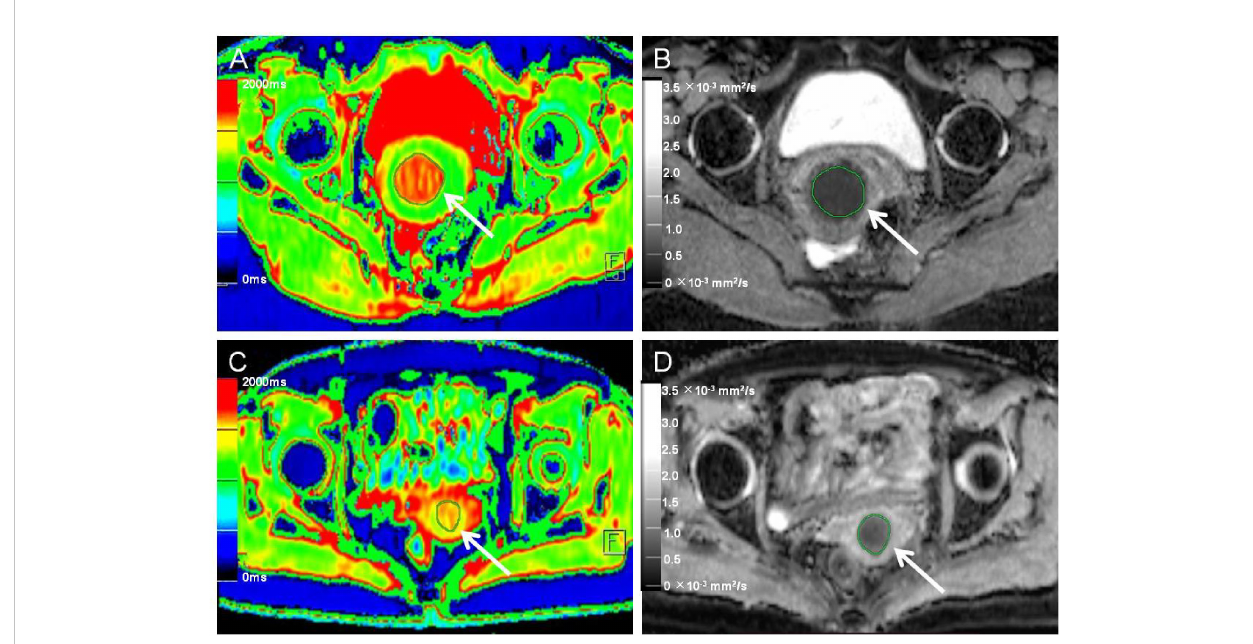
FIGURE 2 Native T1 mapping and apparent diffusion coef fi cient (ADC) images of recurrent and nonrecurrent cervical cancer (CC) in the surgical group. (A, B) A 45-year-old patient with recurrence during the follow-up period. (A) Axial T1 mapping pseudo-color map and (B) axial ADC image. The native T1 and ADC values were 1619.20 ms and 0.68 × 10 − 3 mm 2 /s, respectively. (C, D) A 61-year-old patient without recurrence during the follow-up period. (C) Axial T1 mapping pseudo-color map and (D) axial ADC image. The native T1 and ADC values were 1480.19 ms and 0.82 × 10 − 3 mm 2 /s, respectively. The white arrows in A-D indicate the locations of the lesions.